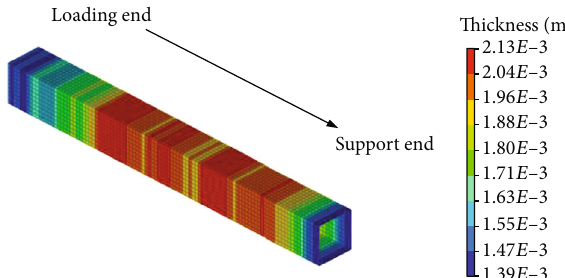
Figure 8: Thickness constraint along circumferential direction.